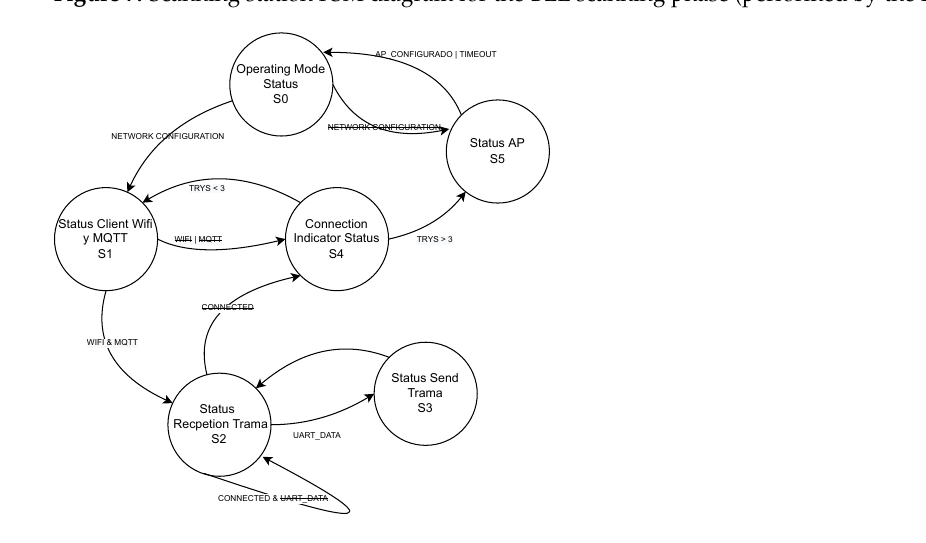
Figure 8. Scanning station FSM diagram for the consolidation of information to the MQTT server (performed by the ESP8266). Taken from